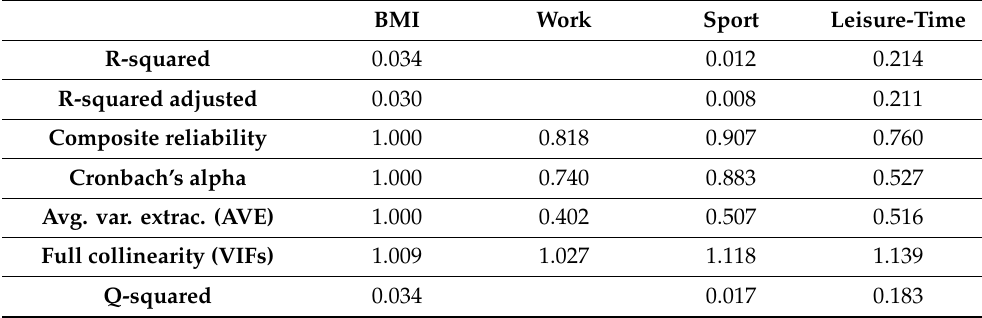
Table 6. Model 2. Latent variables’ coe ffi cients for the relationships between physical activity dimensions and BMI.